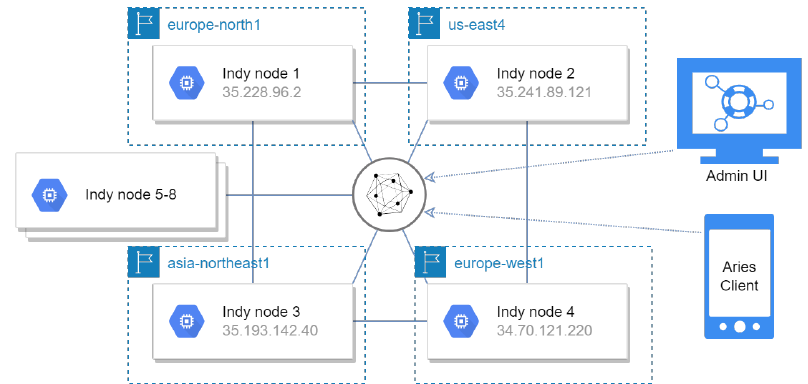
Figure 2. Evaluation architecture in the Google Cloud Platform.